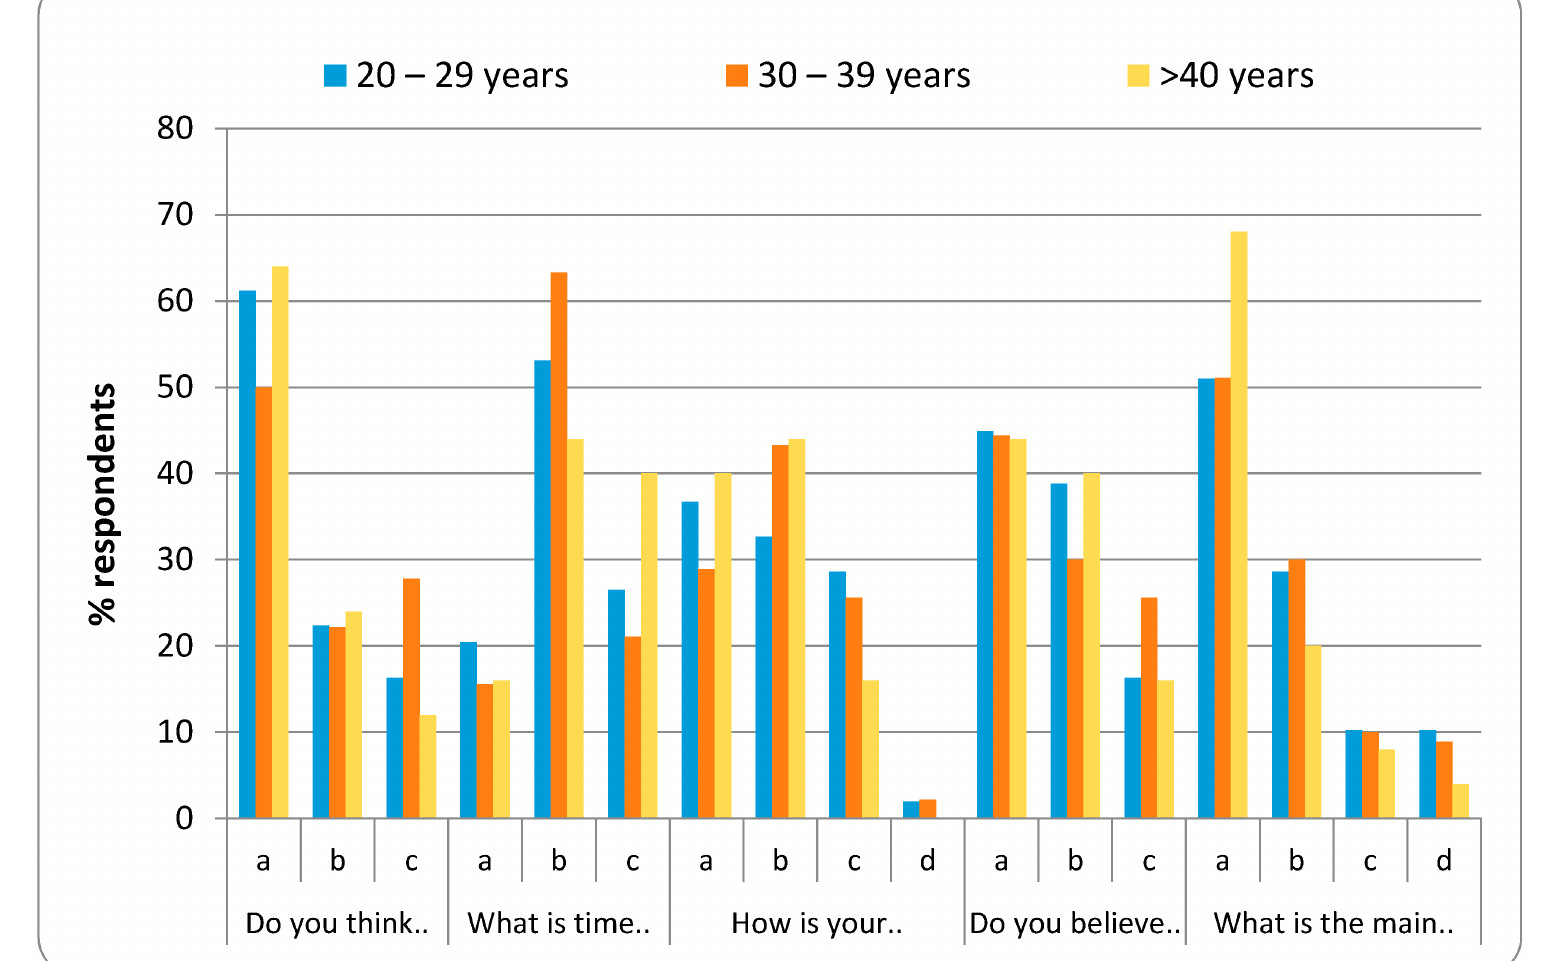
Figure 3. Distribution of responses related to the practice according to age